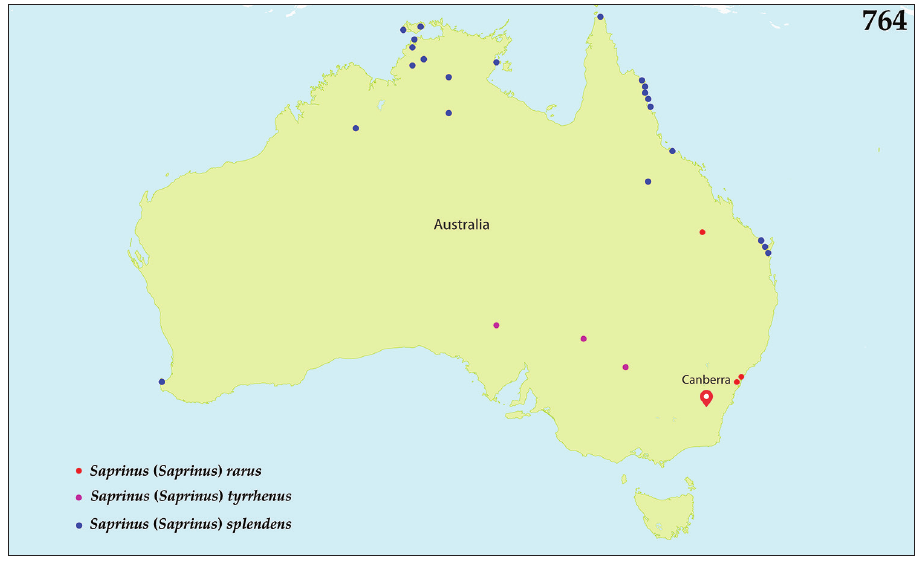
Figure 764. Distribution of Saprinus ( Saprinus ) rarus sp. n., Saprinus ( Saprinus ) splendens (Paykull, 1811) and Saprinus ( Saprinus ) tyrrhenus Blackburn, 1903 in Australia.